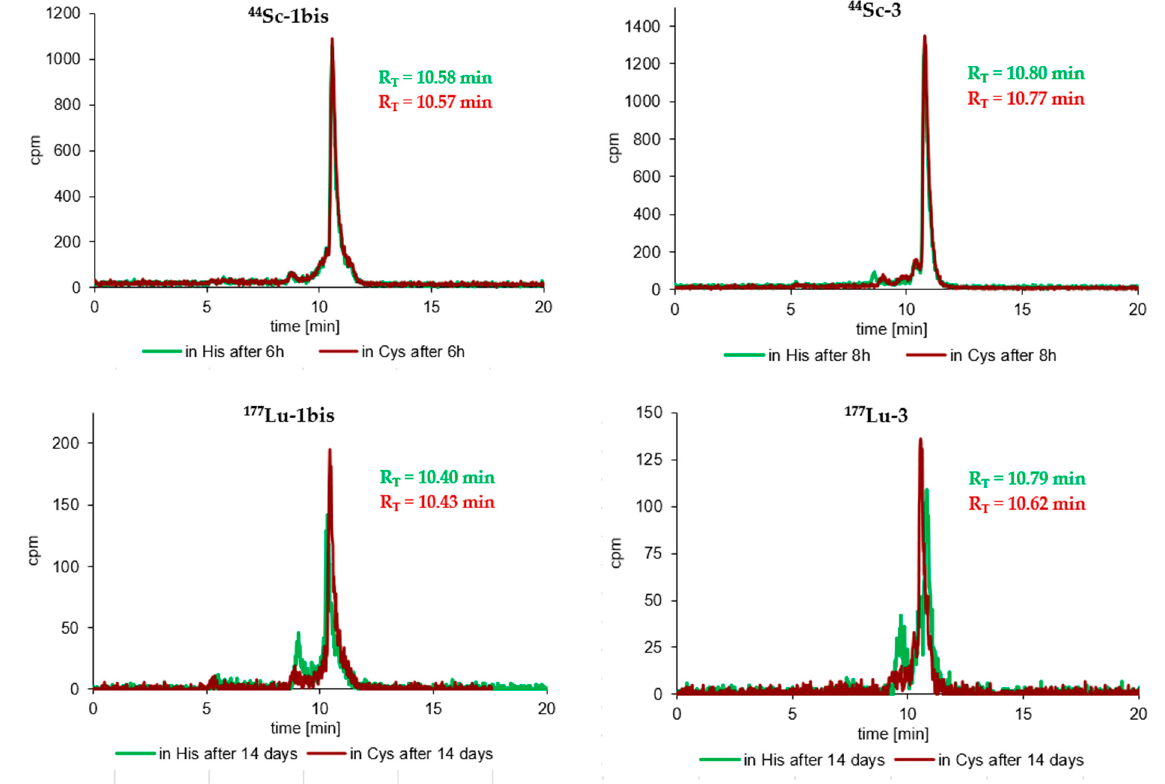
Figure 3. RP-HPLC radiochromatograms of cysteine and histidine stability tests of the 44 Sc-1 , 44 Sc- 1bis , 44 Sc-3, 177 Lu-1bis , 177 Lu-3 (System 3) and 44 Sc-2 (System 4) radioconjugates after the longest incubation time for a given radioconjugate.